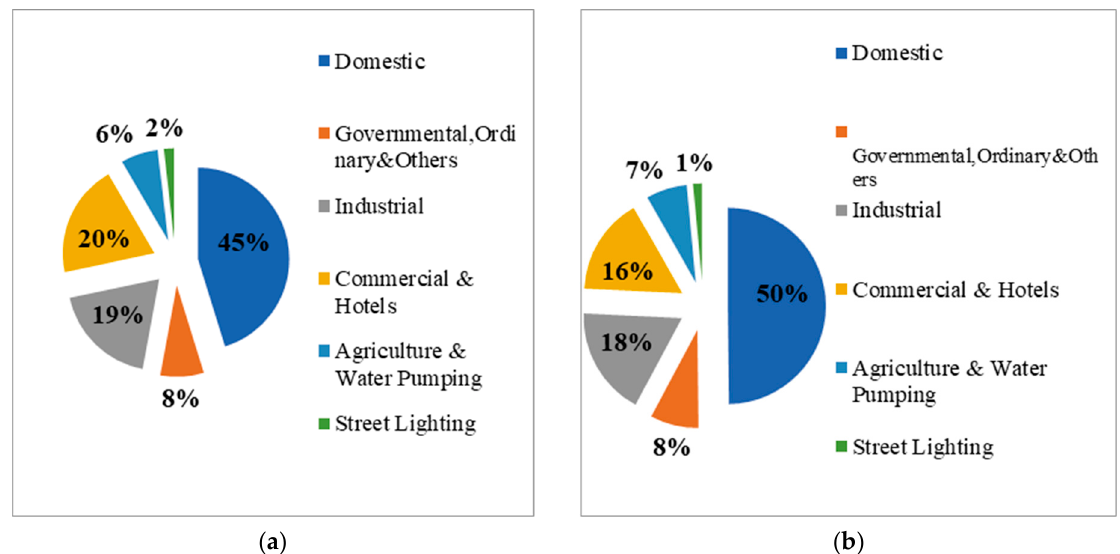
Figure 11. Electricity consumption by sector at JEPCO‘s area. ( a ) 2019, ( b ) 2020.